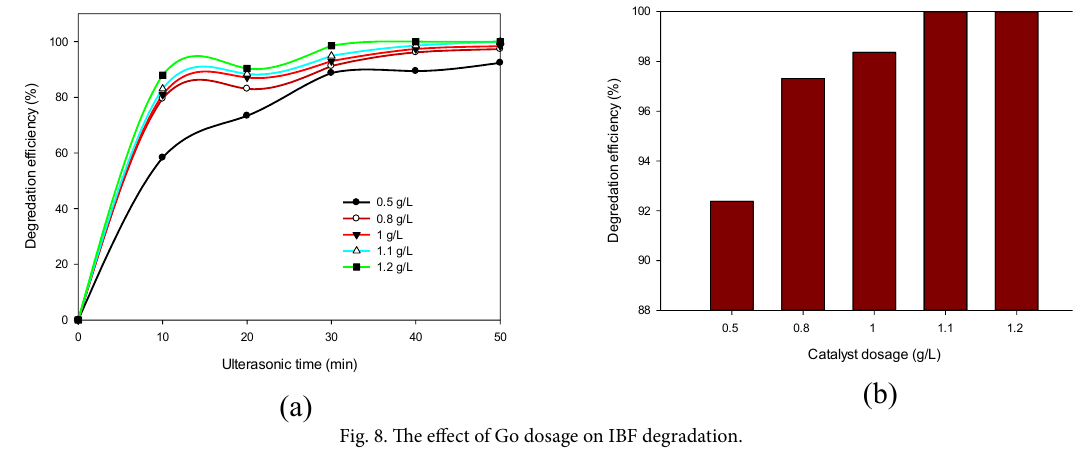
Fig. 8. The effect of Go dosage on IBF degradation.